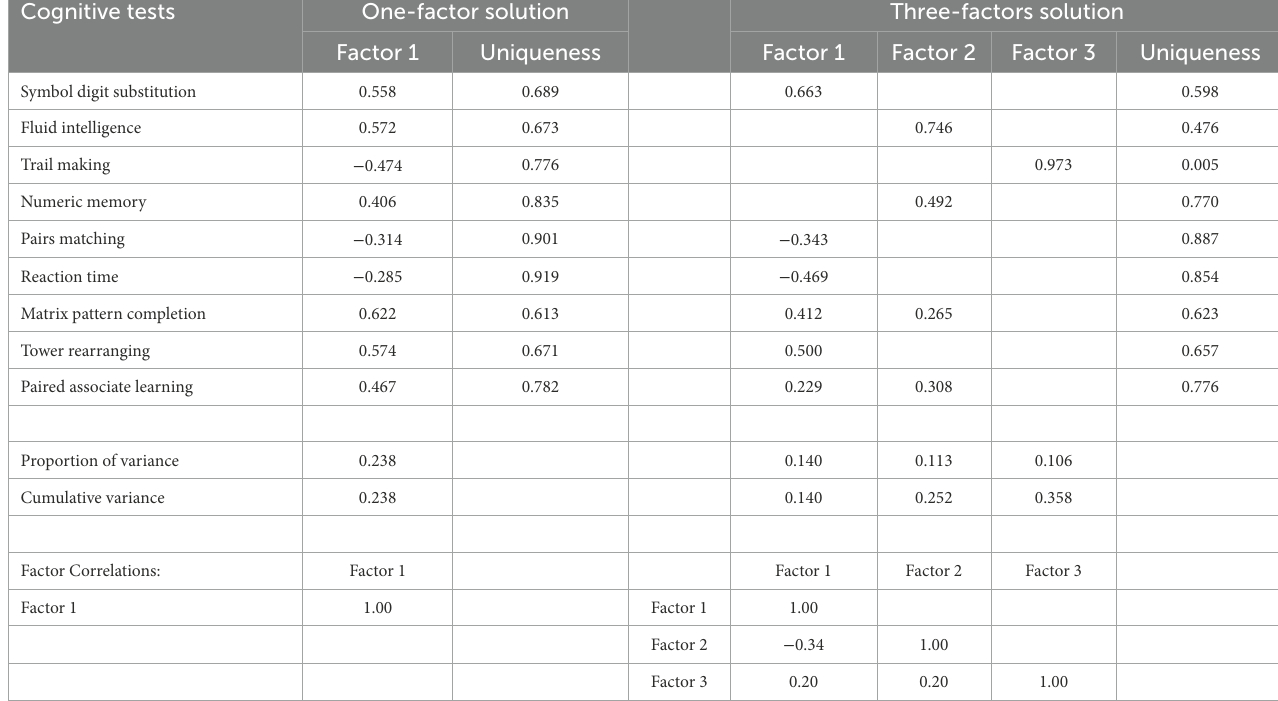
TABLE 2 One-factor and three-factors solutions for cognitive tests in the UK